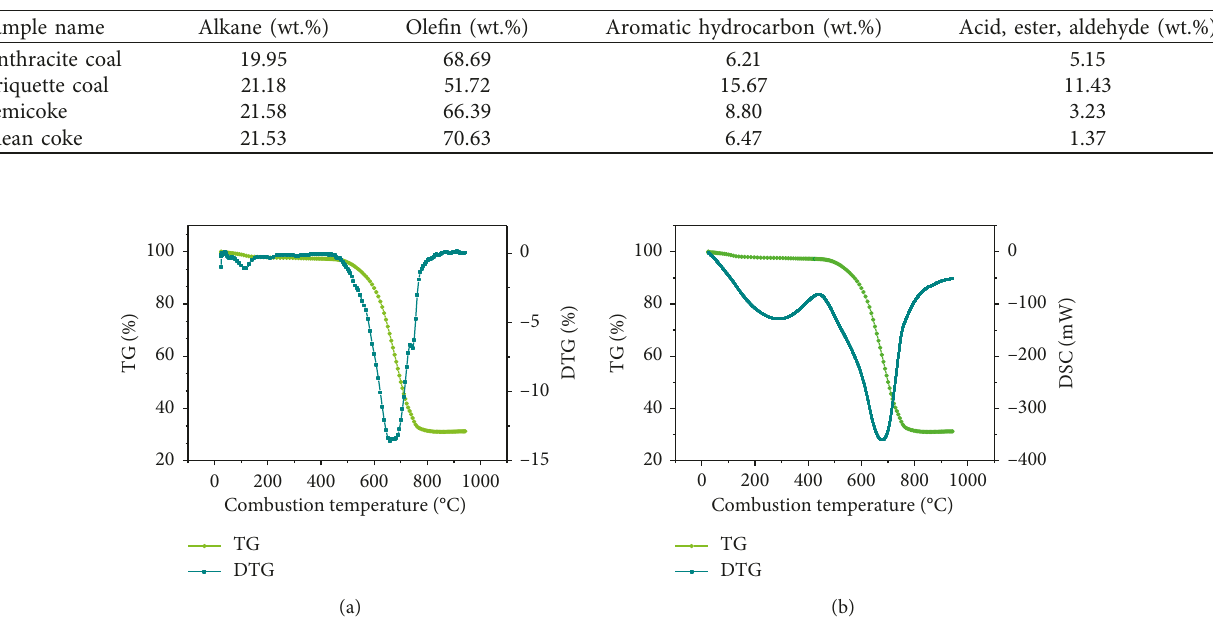
Table 4: Analysis of the components in volatile